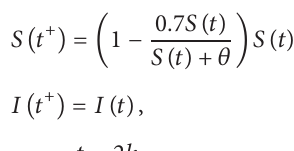
periodic solution (𝑆 ∗ (𝑡), 0) , which is globally asymptotically